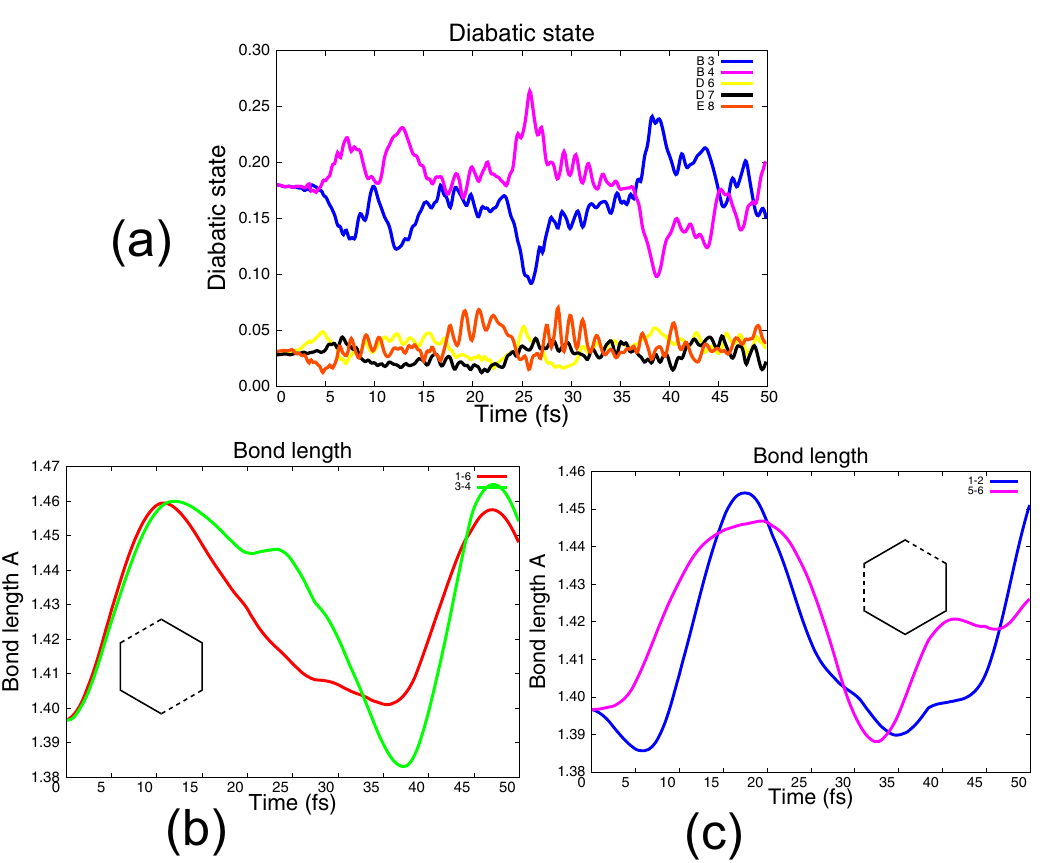
Fig. 4 Results of 8-state Qu – Eh dynamics using the coherent superposition obtained from photoelectron cross sections. The labels E 8 , D 7 , and D 6 refer to the singly ionized diabatic states according to Fig. 2a in Galbraith et al. 12 (and Figure S1). The atom labels 1 – 6 on the carbon atoms start at the top of the hexagon and increment clockwise. a Populations of the diabatic states. b , c Bond vibrations for dominant stretches. The data in all panels are obtained by weighting the gwp by gross populations 26